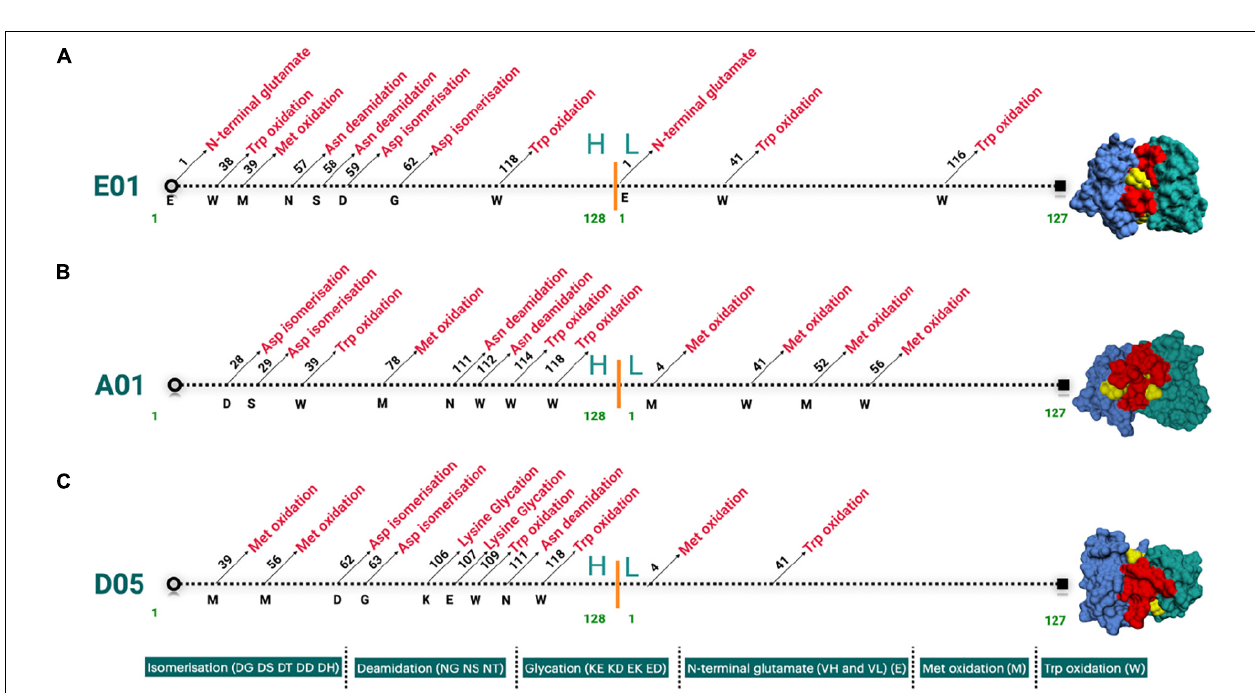
FIGURE 3 | (A–C) Landscape of cloned antibodies sequence liabilities depicted structurally for both heavy and light chain sequences. The figure represents the sequence liabilities of various clones considered in this work, i.e., E01, A01, and D05 clones, respectively.